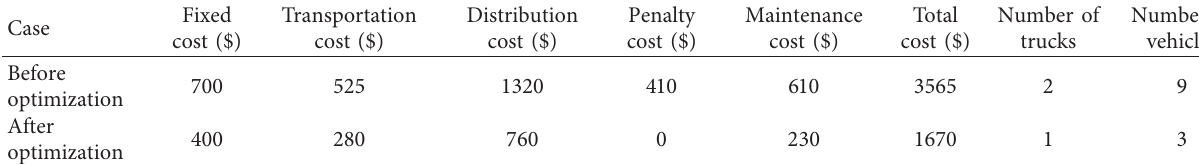
Table 1: Comparison before and after 2E-LRPTWTRS